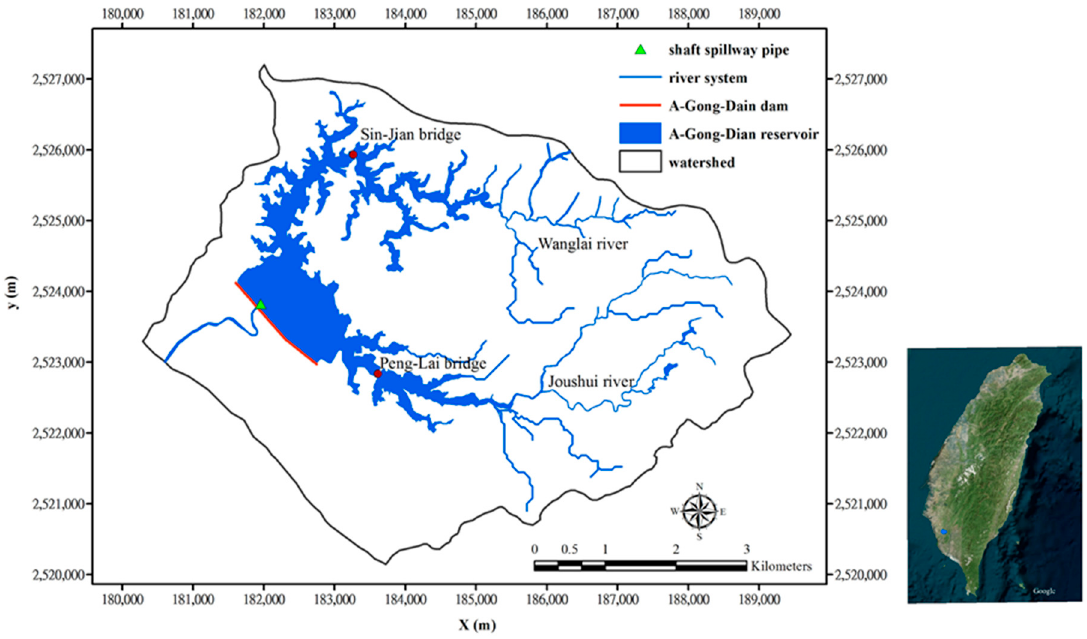
Figure 1. A-Gong-Dian Reservoir watershed and its river system.